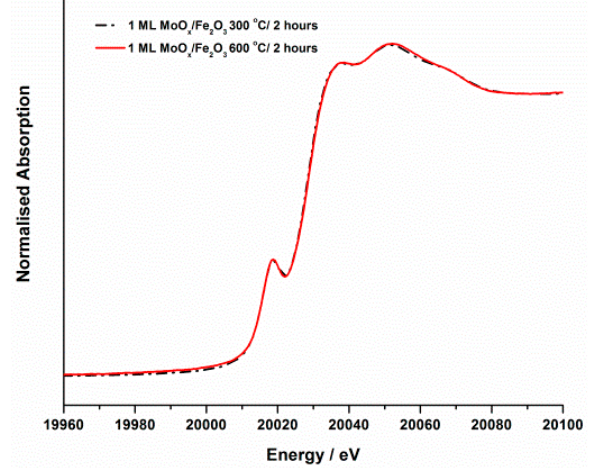
Figure 11. Normalised XANES spectra of 1ML MoO 3 /Fe 2 O 3 catalysts annealed to 300 and 600 ° C. Spectra are identical across the calcination range. Image adapted from C. Brookes et al. , J. Phys. Chem. C , 2014, 118 (45), pp. 26155–26161 [7].